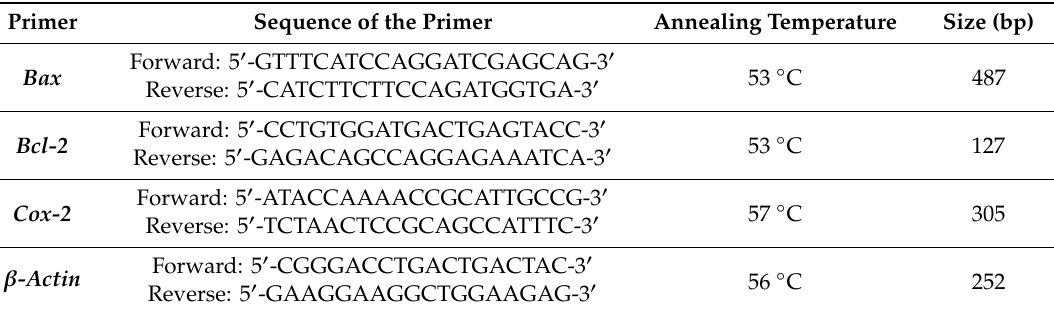
Table 1. Primers used in reverse